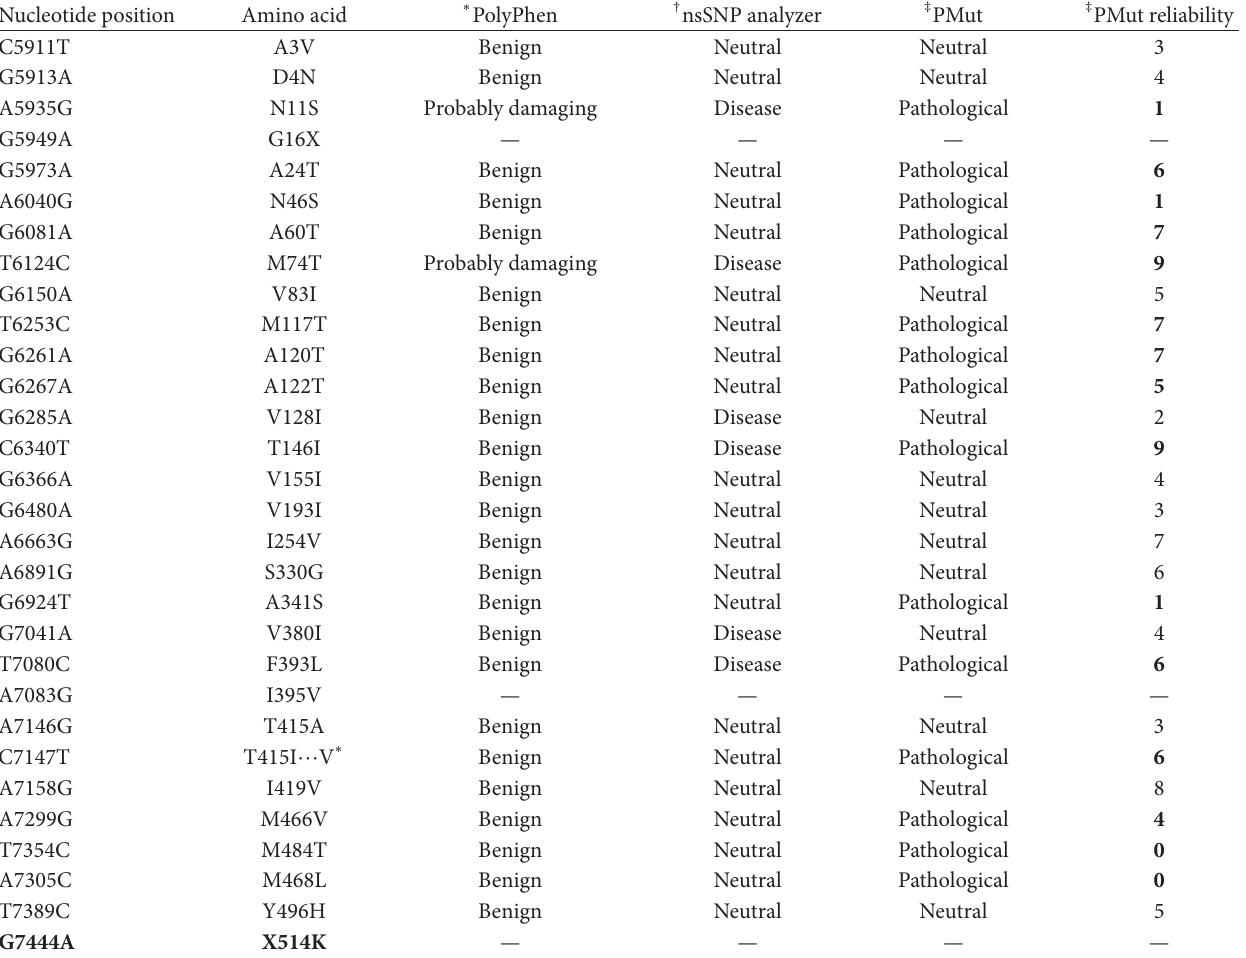
T 3: Missense mutations’ computation methods and prediction of phenotypic effect.